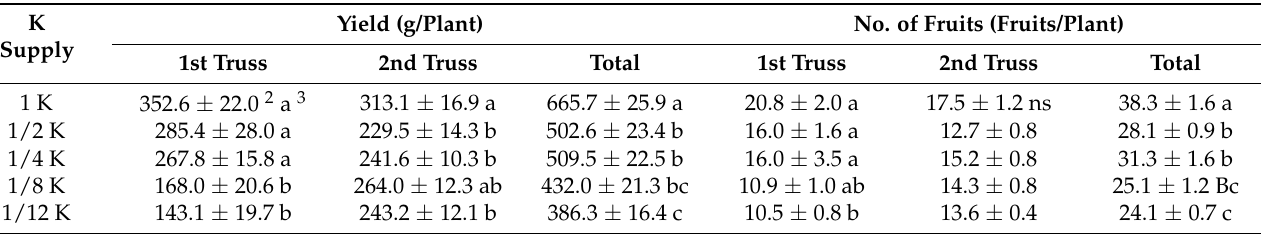
Figure 4. Cumulative water uptake per plant under five quantitative K-supply regimes for four months in hydroponically grown cherry-type tomato ‘Carol 10’. Table 3. Fruit marketable yield 1 of hydroponically grown cherry-type tomato ‘Carol 10’ under five quantitative K-supply regimes.